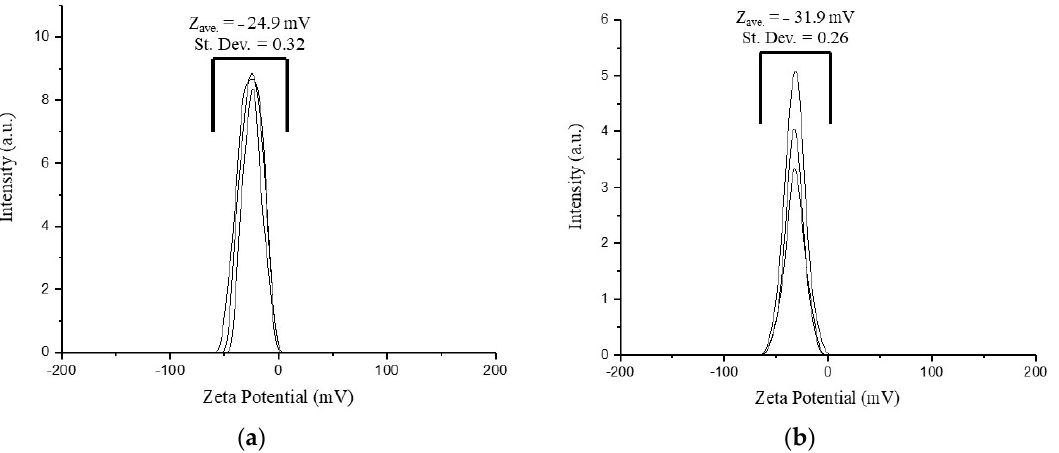
Figure 17. ζ -potential diagram measured in triplicate for the ( a ) Gd 2 O 3 :Eu 3+ and ( b ) SiO 2 - Gd 2 O 3 :Eu 3+ (1%) nanoparticles, in which negative potential values are found for both samples.